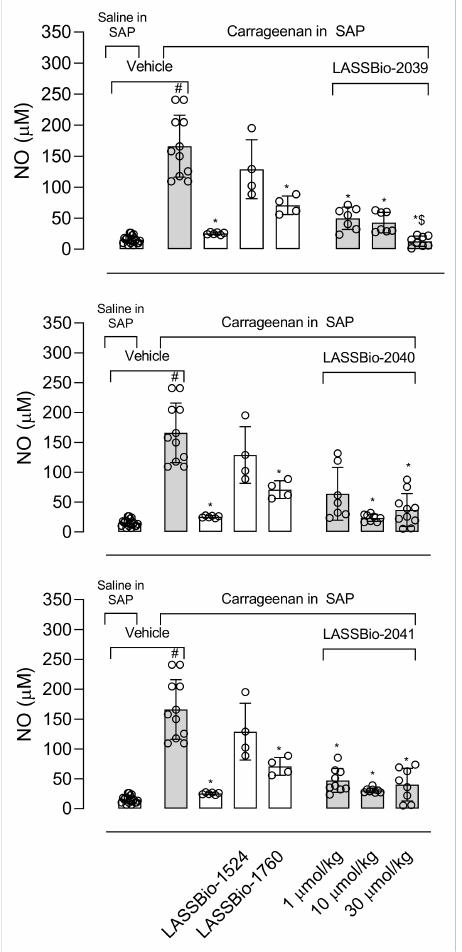
Figure 7. LASSBios reduce nitric oxide (NO) produced in the inflammatory exudate. Animals were pre-treated with vehicle, LASSBio-1524 or LASSBio-1760 (at 30 µ mol/kg), dexamethasone (6.5 µ mol/kg) or LASSBios (doses of 1, 10 or 30 µ mol/kg) 1 h before injection of saline (NaCl 0.9%) or carrageenan into the SAP. Results are expressed as media ± SD ( n = 5–12). Where no error bar is shown it is because it is smaller than the symbol. Statistical significance was calculated in GraphPad Prism 8.0 (San Diego, CA, USA) using analyses of variance (ANOVA) followed by Tukey post-test with p < 0.01 (#) when comparing vehicle-treated group that received carrageenan injection into the SAP with vehicle-treated group that receives saline into the SAP. p < 0.01 (*) when comparing dexamethasone- or LASSBios-treated group that received carrageenan injection into the SAP with vehicle-treated group that receives carrageenan into the SAP. p < 0.01 ($) when comparing LASSBio-2039-treated group that received carrageenan injection into the SAP with LASSBio-1760-treated group that receives carrageenan into the SAP. Data for the original compounds (LASSBio-1524 and LASSBio-1760) are original, independent duplicates of past results and have not been published